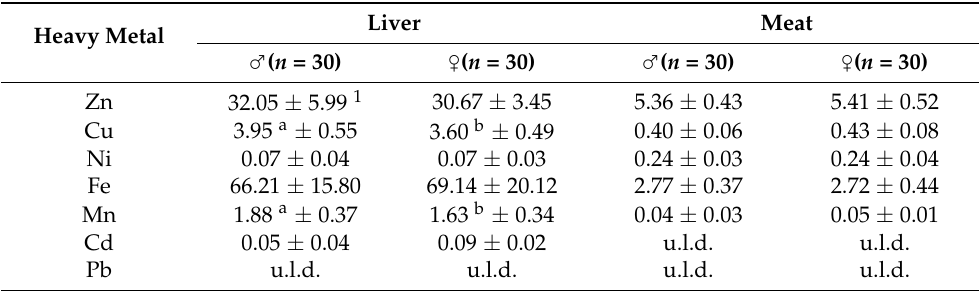
Table 8. The content of elements in the liver and meat (m. longissimus lumborum) of females and males in mg/kg